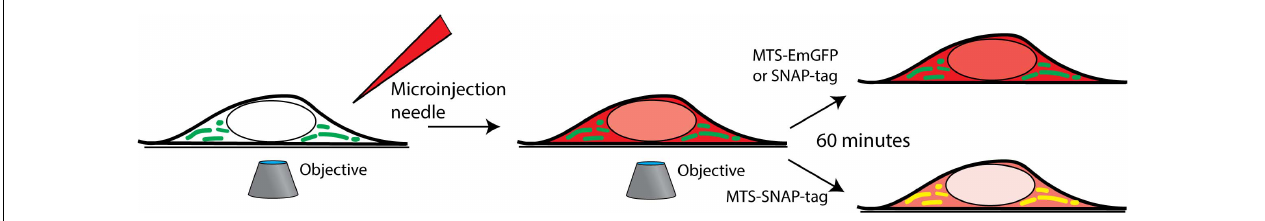
FIGURE 1 | Microinjection is performed on the cells in the field of view of an inverted microscope, and time-lapse imaging is performed. The cells are grown in a 35 mm glass-bottom imaging dish and placed in an incubator mounted on an inverted confocal fluorescence microscope. The microinjection of the protein (red) is performed, and co-localization (yellow) with the mitochondria (green) is tracked over time.